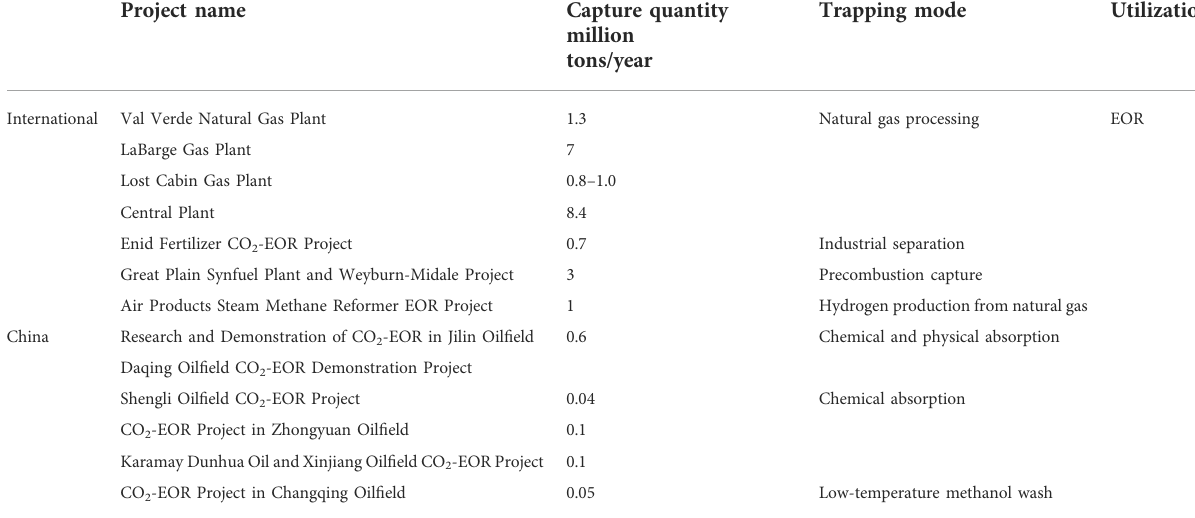
TABLE 1 International CCUS-EOR projects [modi fi ed according to Xiang et al.